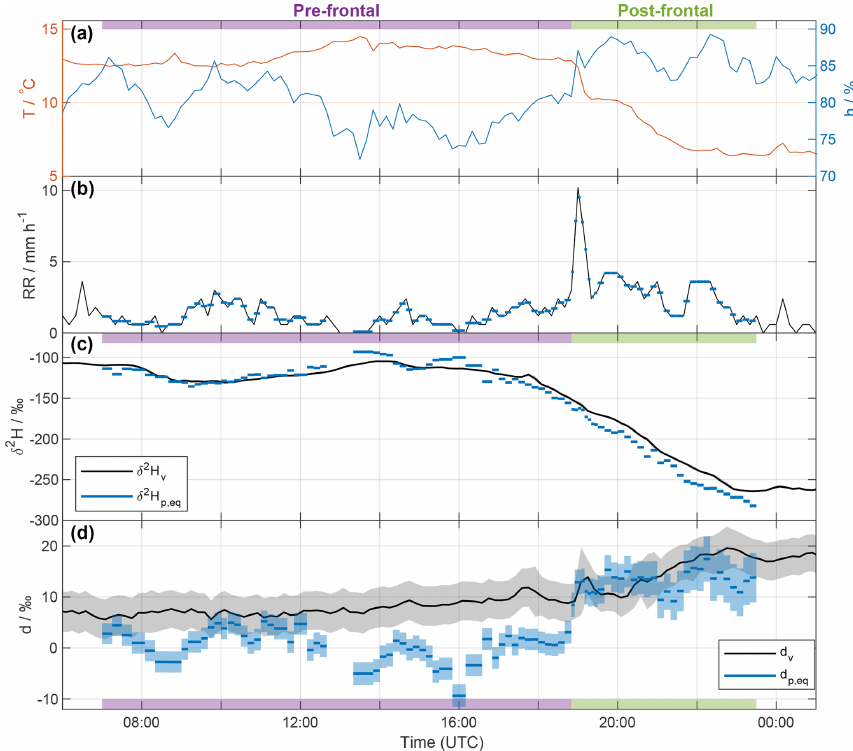
Figure 2. Time series of observations in Zurich between 06:00UTC 20 November and 01:00UTC 21 November 2015. (a) Local temperature ( T ; red) and relative humidity ( h ; blue) measured by the meteorological station. (b) Rain intensity from the rain gauge (black). Blue bars indicate the average values for each rain sample period. (c) δ 2 H of near-surface vapour (10min averaged δ 2 H v ; black line) and of the equilibrium vapour from precipitation ( δ 2 H p , eq ; blue bars). The width of the blue bars denotes the period over which the rain samples were collected. (d) Same as in (c) , but for d . The calibrated uncertainties are indicated by the shaded areas (hardly or not visible for δ 2 H v and δ 2 H p , eq ). Pre- and post-frontal periods are indicated with purple and green bars,